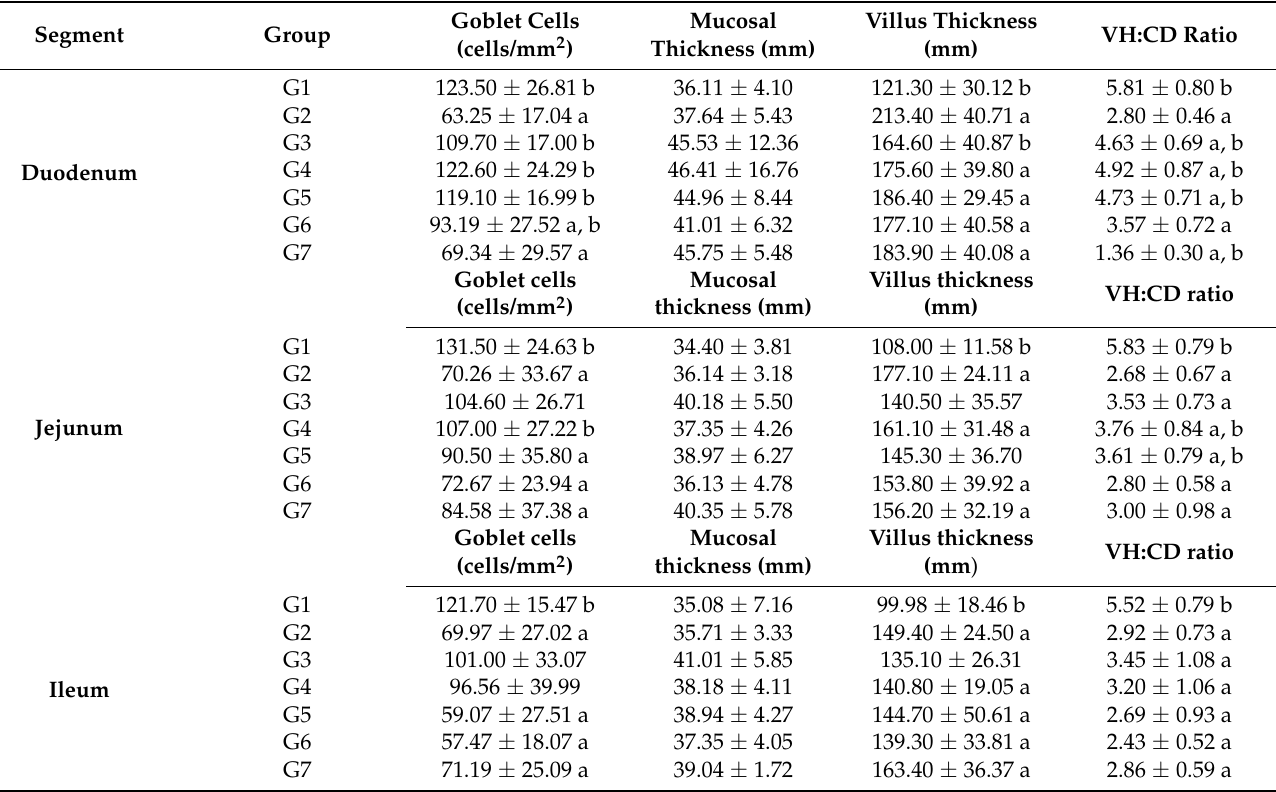
Table 4. Histomorphometric measurements of the small intestine in broilers prophylactically treated with toltrazuril formulations at 21 days of